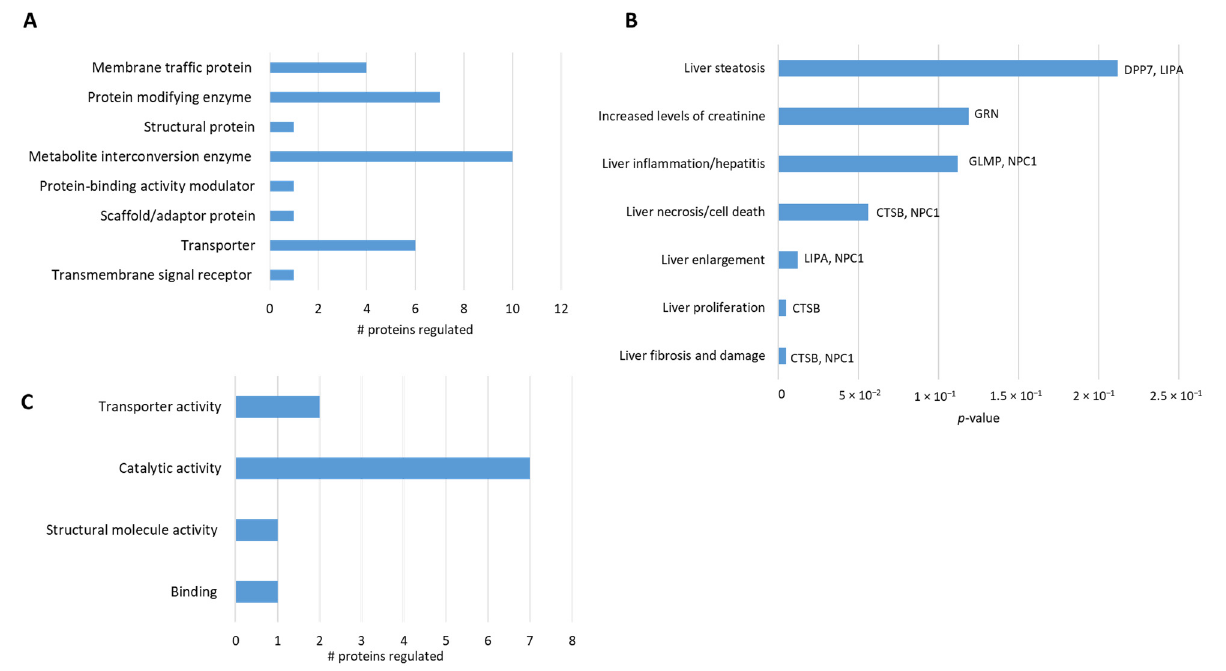
Figure 4. Analysis of differentially expressed lysosomal and mitochondrial proteins. ( A ) The differentially expressed 47 lysosomal proteins were mapped to GO categories (protein class). The bars represent the number of proteins associated with the respective terms. ( B ) The bar chart represents the lysosomal protein toxicity function filtered by hepatotoxicity. The bars represent the p -value and in each bar, the protein that participates in the process is labeled. ( C ) The 10 differentially expressed mitochondrial proteins were mapped to the GO categories (protein class). The bars represent the number of proteins associated with the terms.